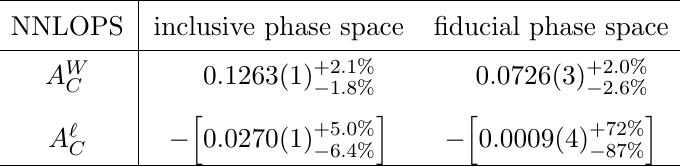
Table 3 . NNLOPS predictions for the charge asymmetry for W -bosons and charged leptons in W + W (cid:0) production. The (cid:12)ducial volume is de(cid:12)ned in table 1 (including the jet-veto